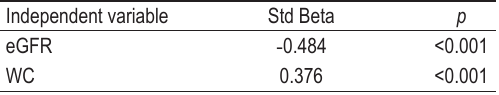
TABLE 4. Multiple linear regression analysis with cystatin C as dependent variable in all participants Independent variable Std Beta